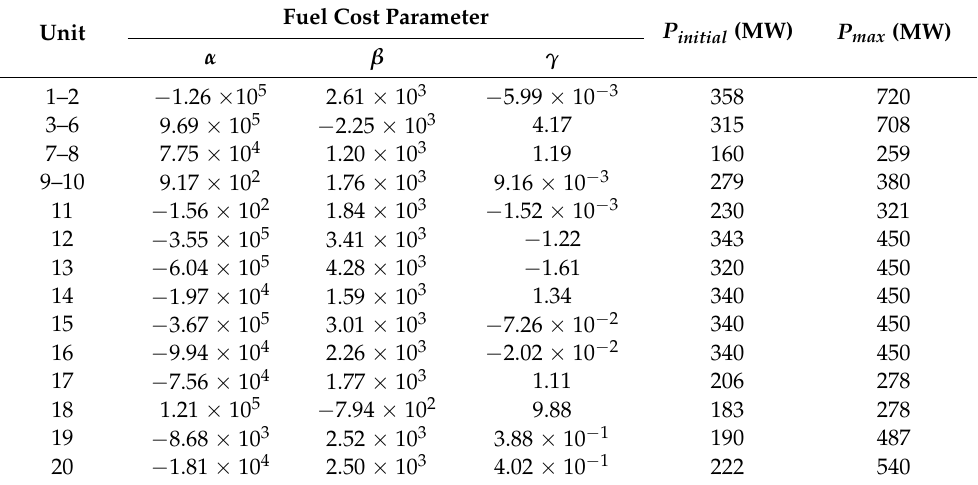
Table 1. Natural gas combined cycle unit fuel cost parameters and fuel cost parameters for the natural gas combined-cycle unit and the initial and maximum.